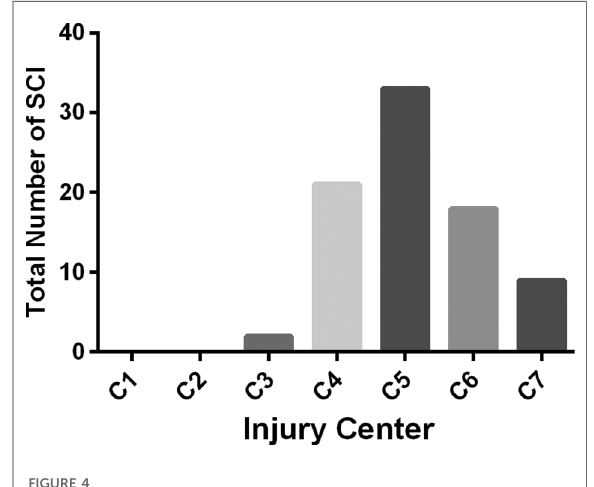
FIGURE 4 Number of spinal cord injuries at various levels.